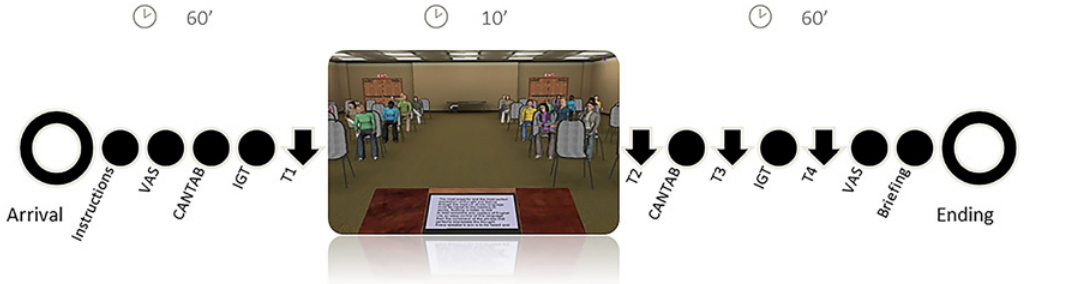
Fig 1. Schematic representation of the